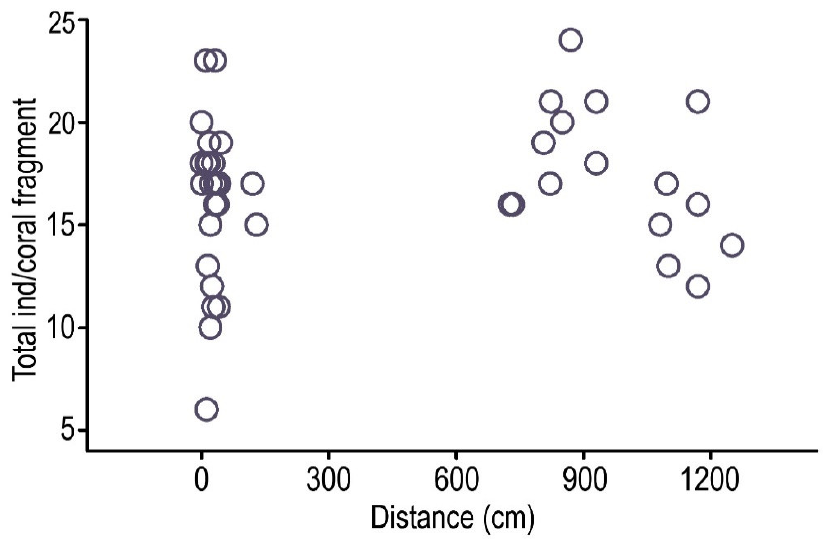
Figure 6. Distances between fragments. Distances represent migration between colonies, as there is no pattern between recruitment and distances; these do not influence the recruitment of Pocillo- pora colonies.